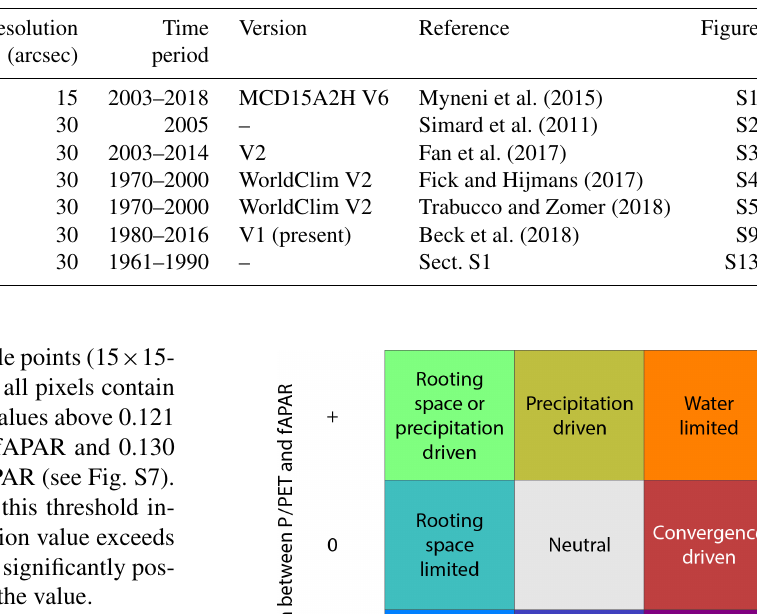
Table 1. Summary of the datasets used in this study. The time period column describes the time frame of the input data of the specific studies to generate the datasets used here.